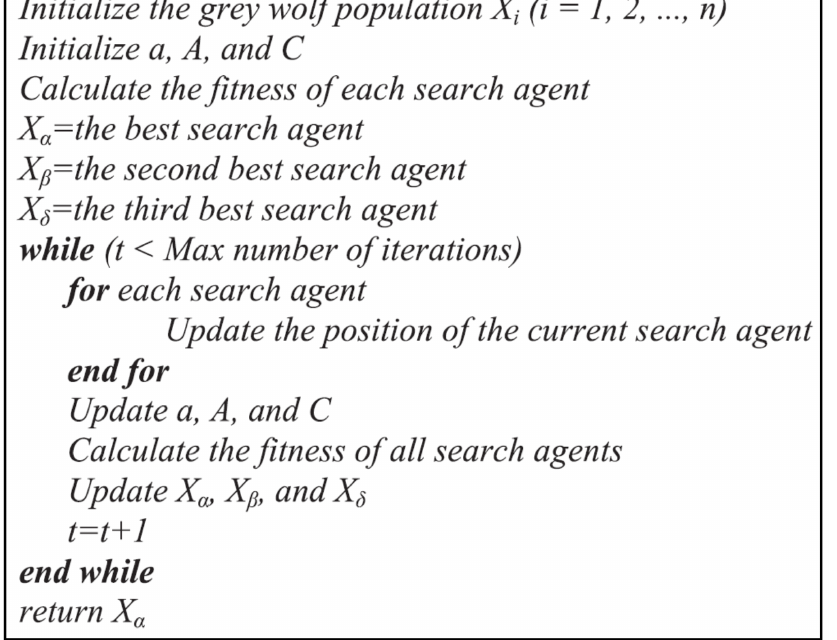
Figure 2. Pseudo-code of Grey Wolf Optimization (GWO)